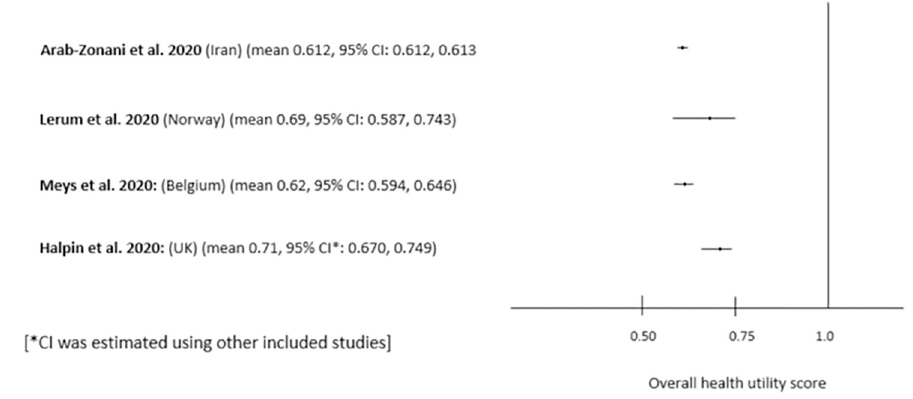
Fig 3. Mean EQ-5D-5L scores of Long Covid reported in different studies. [Note: Only those studies that reported mean EQ-5D-5L scores were presented in the Fig 3].